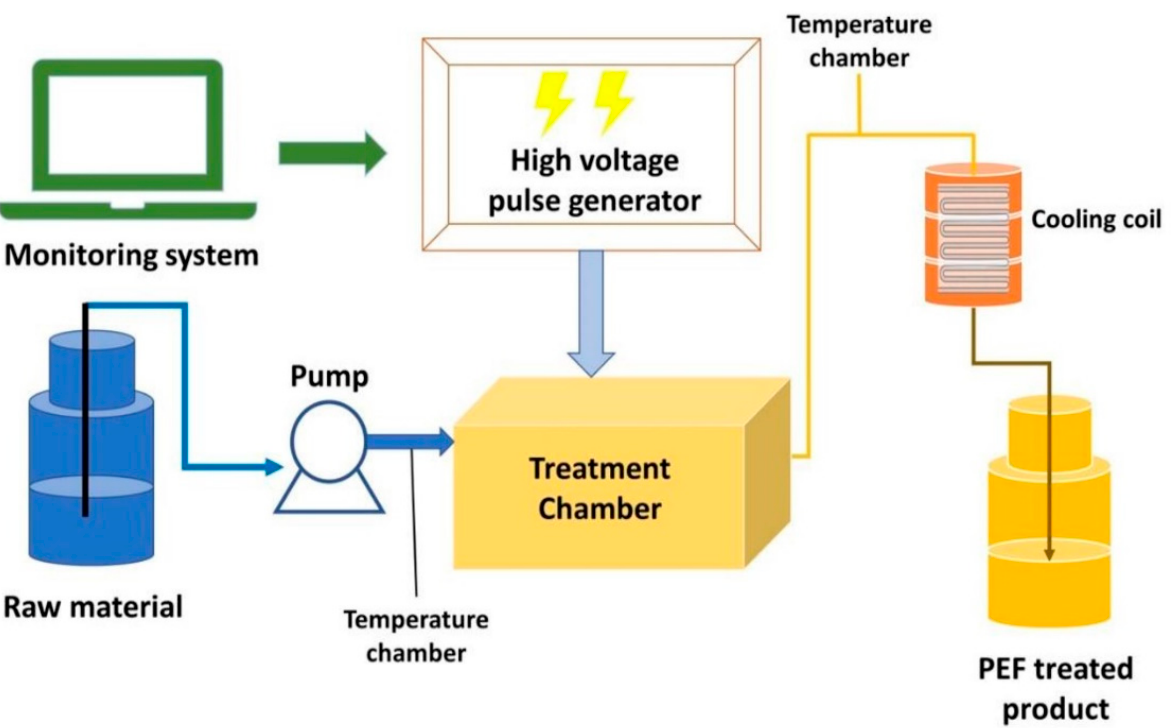
Figure 1. Diagram of a possible continuous PEF device used to treat food samples (adapted from Taha, et al. [64] (reprinted from Pulsed Electric Field: Fundamentals and Effects on the Structural and Techno-Functional Properties of Dairy and Plant Proteins. Taha, Ahmed, Casanova, Federico Šimonis, Povilas Stankeviˇc, Voitech Gomaa, Mohamed A. E. Stirk˙e, Ar¯unas; Foods 2022; Vol. 11; Issue